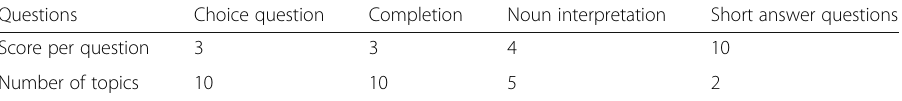
Table 2 Analog test paper